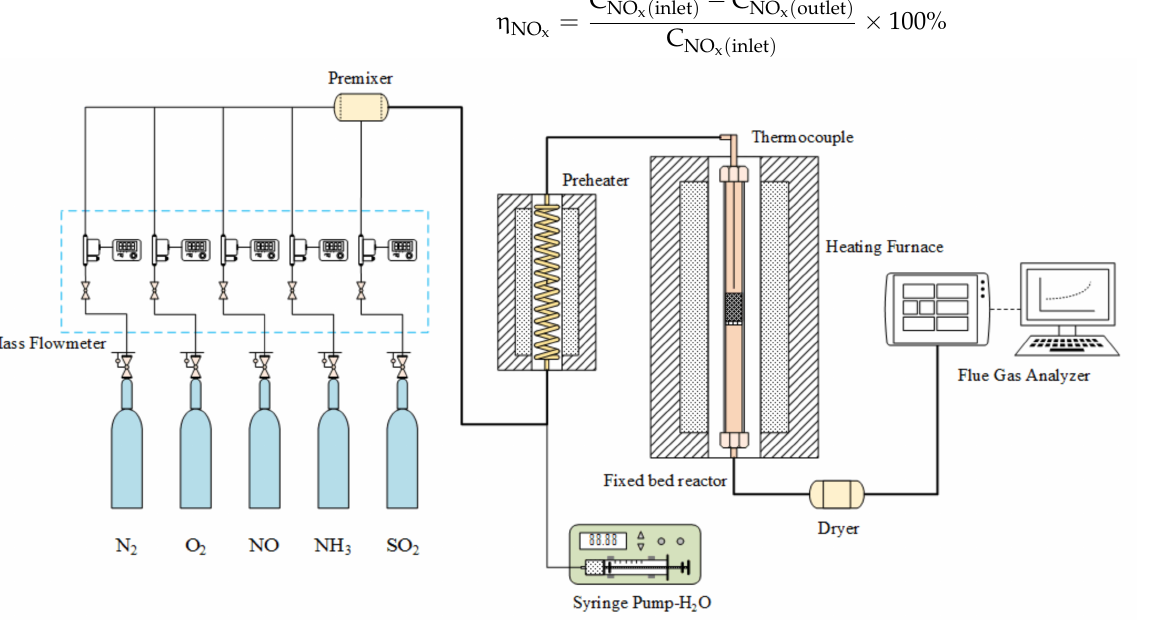
Figure 1. Fixed bed